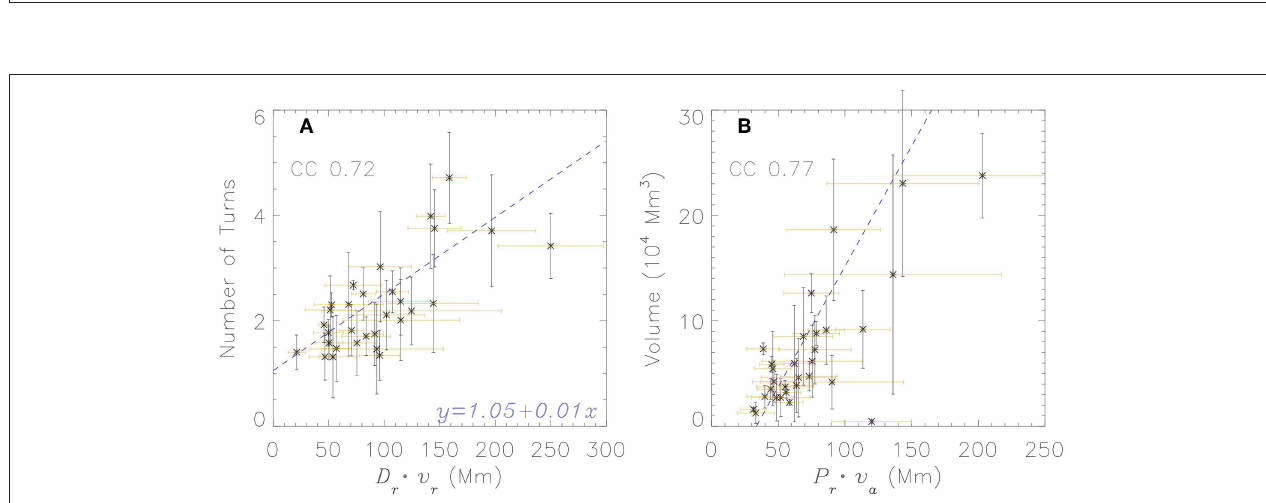
FIGURE 7 | (A) shows the correlation between the product of the duration and speed of the rotational motion and the total number of turns. (B) demonstrates correlation between the twist pitch and volume of jets (see Equation 3). Black vertical lines are errors of the total number of turns. Orange horizontal lines are propagated errors of corresponding parameters. Blue lines are the linear fitting results of the scattered points with error bars taken into account.